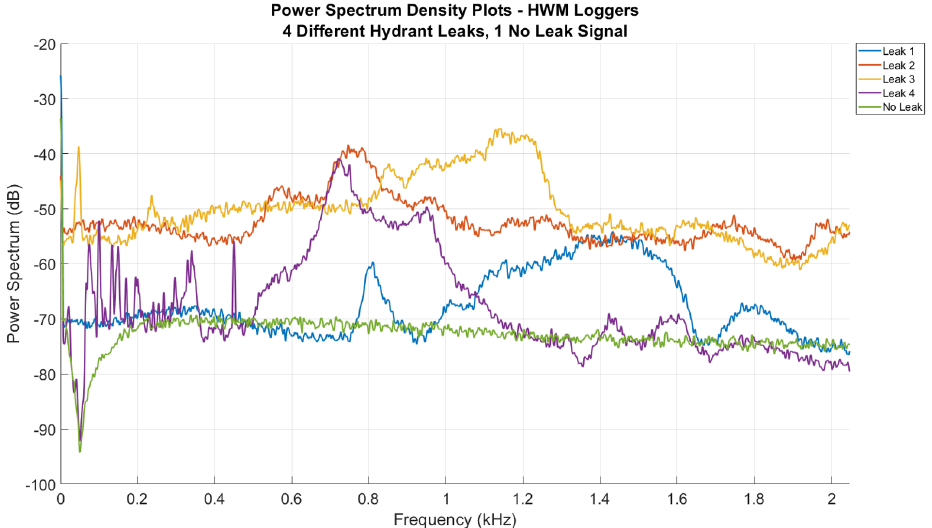
Figure 6. PSD plot: four different hydrant leak signals (loggers on leaking